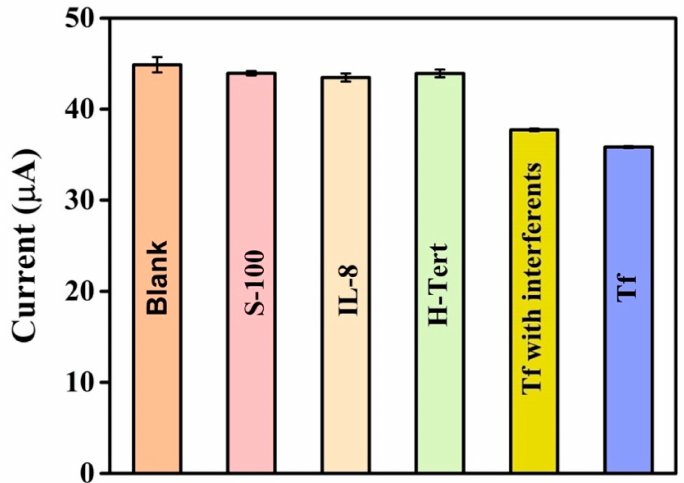
Figure 5. Specificity analysis of the immunosensor showing the high specificity of the immunosensors toward the Tf antigen in the presence of different interferents. Tf with interferents includes a mixture of all possible interferents and